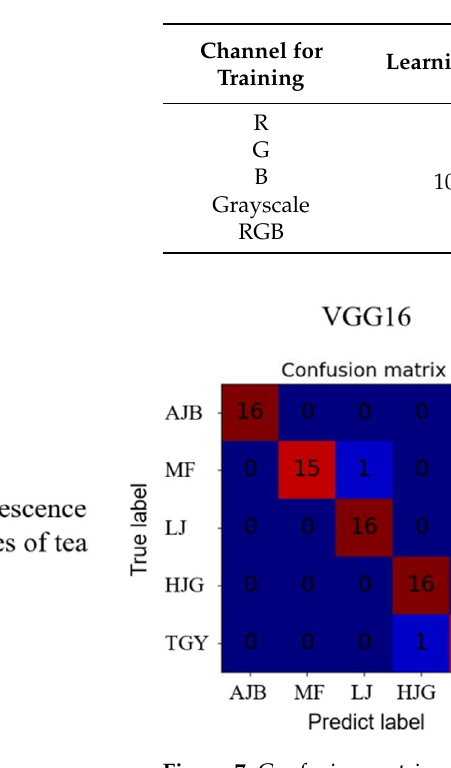
Figure 7. Confusion matrix of fluorescence RGB images of tea.